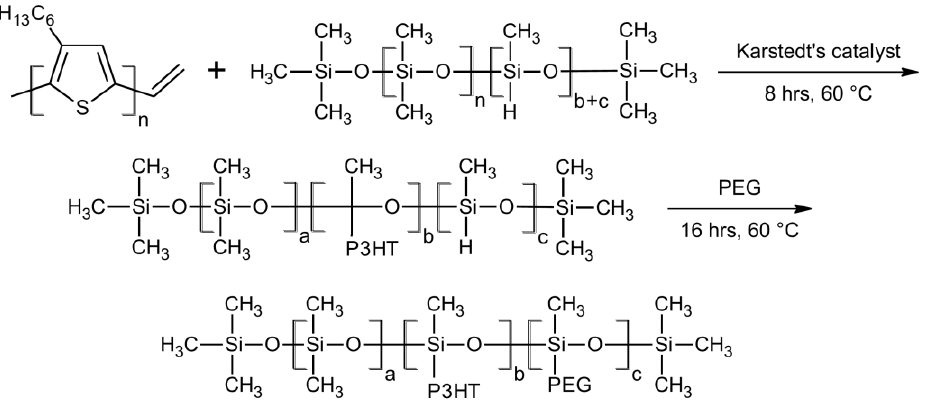
Figure 1. Scheme of the poly(3-hexylthiophenes) (P3HT) graft copolymer synthesis route.